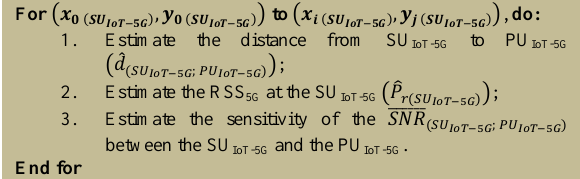
Table 1 . Estimating